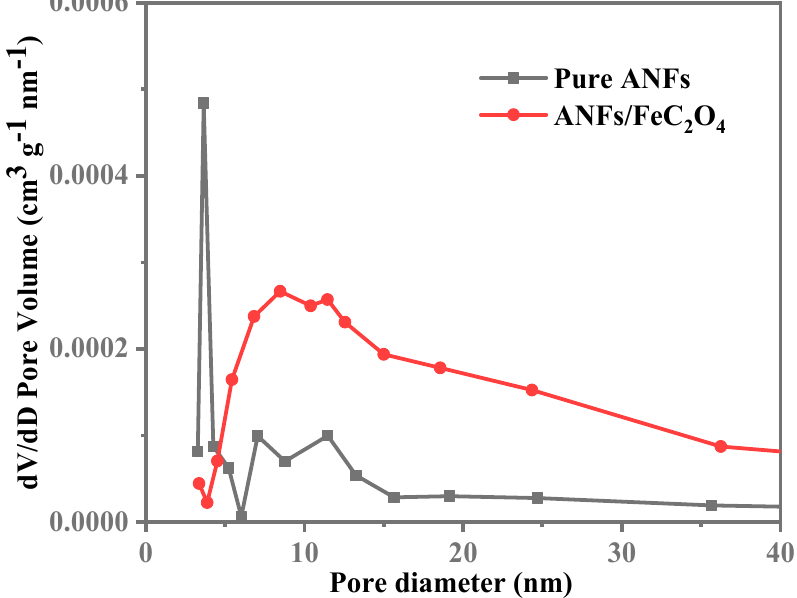
Figure 4. Pure ANFs and ANFs/FeC 2 O 4 pore size distribution.